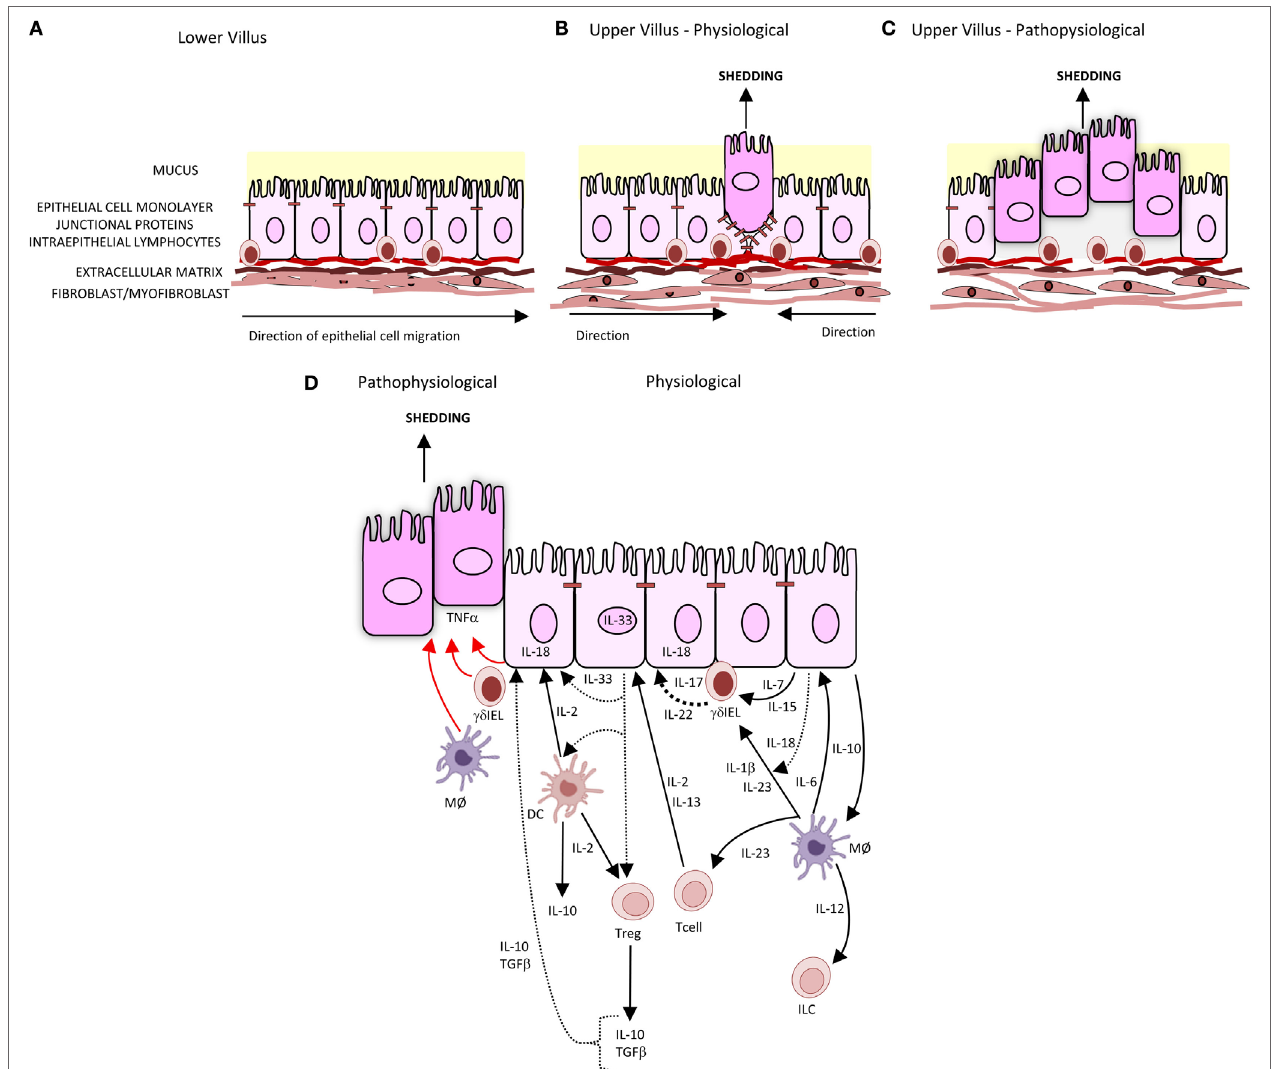
FiGURe 1 | Intestinal epithelial cell shedding. (A) In health, epithelial cells migrate up the villus from the base of crypt to the tip. This is achieved through the crawling movement of the epithelial cells through epithelial–substratum interactions between integrins, heparin sulfate proteoglycans, and extracellular matrix. (B) At the villus tip, physiological cell shedding with redistribution of tight junctional proteins. (C) Pathophysiological cell shedding with multiple cells shed from a single site leading to barrier loss. (D) Immunological regulation of cell shedding. Under pathophysiological conditions, TNF α is released by γδ IELs, macrophages (MØ), and intestinal epithelial cells (represented by red arrow) resulting in cell shedding. Pathways of cytokines secreted by intestinal epithelial cells, T cells, T regulatory cells (Tregs), and dendritic cells (DC) involved in intestinal epithelial barrier integrity are represented by black arrows, with dashes representing cytokines which have been identified but specific role in barrier integrity and subsequent regulation of cell shedding not yet